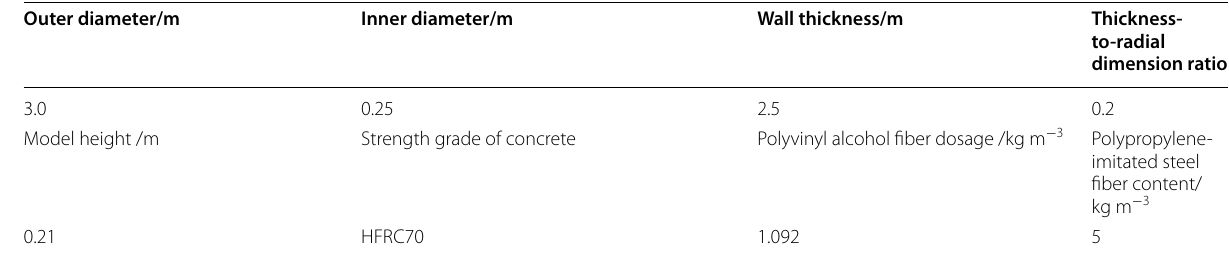
Table 10 Design parameters of model shaft wall structure.